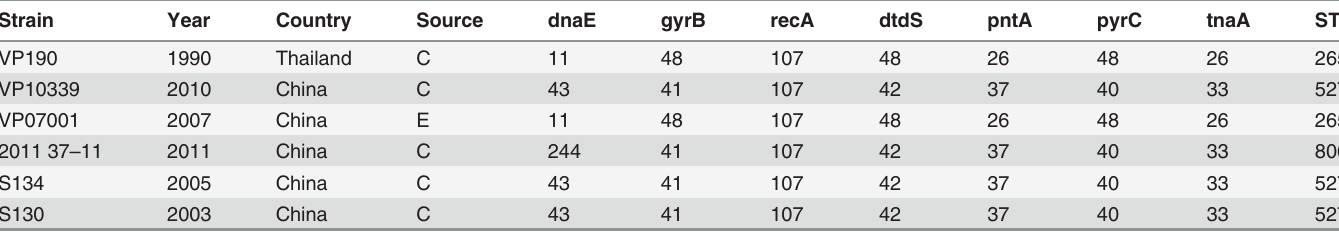
Table 4. V . parahaemolyticus strains with recA allele 107 available at the MLST V . parahaemolyticus database.